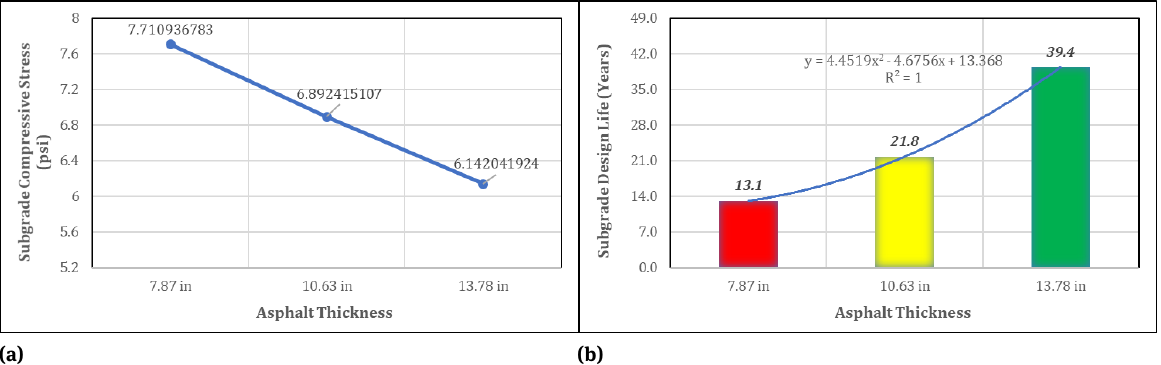
Figure 22: Influence of asphalt thickness on subgrade compressive stress (a) and on subgrade service life (b) in asphaltic overlayment track.